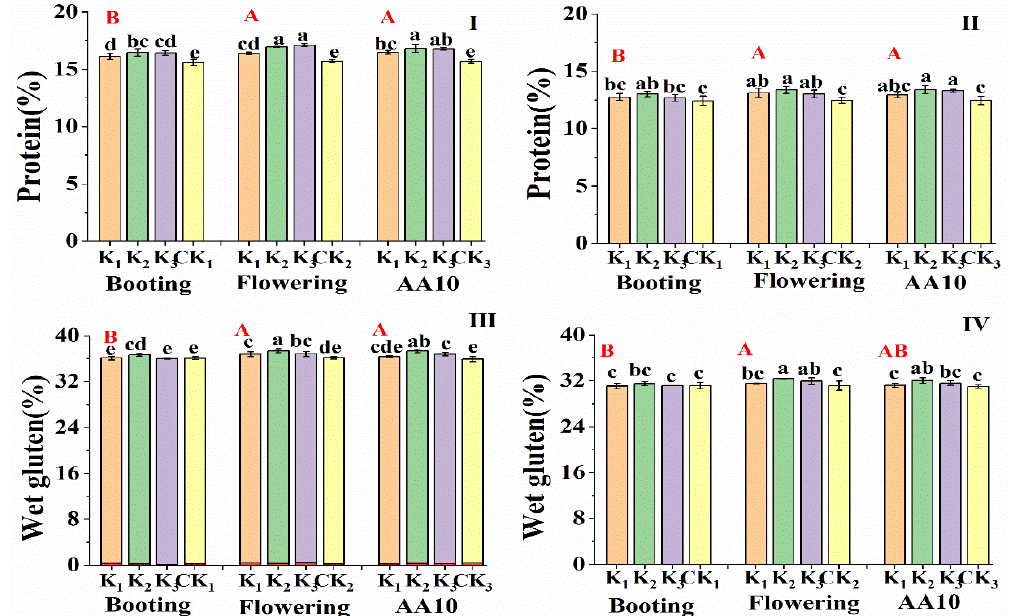
Figure 3. Effects of potassium foliar application on the protein and wet gluten of wheat with Xinong 20 and Xiaoyan 22. I and III represented Xinong 20, and II and IV represented Xiaoyan 22. Booting (BBCH 48), Anthesis (BBCH 65), and AA10 (BBCH 71): Potassium fertilizer foliar sprayed at booting stage, anthesis stages, and 10 days post anthesis, respectively. K 1 , K 2 , and K 3 represented the application concentration of potassium 30, 60, and 90 mmol L − 1 , respectively. CK: Same amount of deionized water was sprayed on the leaves. Vertical bars represent the mean values ± standard deviation (n = 3). Different lower-case letters indicate a significant difference ( p < 0.05). Different capital letters indicate a significant difference ( p < 0.05) among different spraying stages.